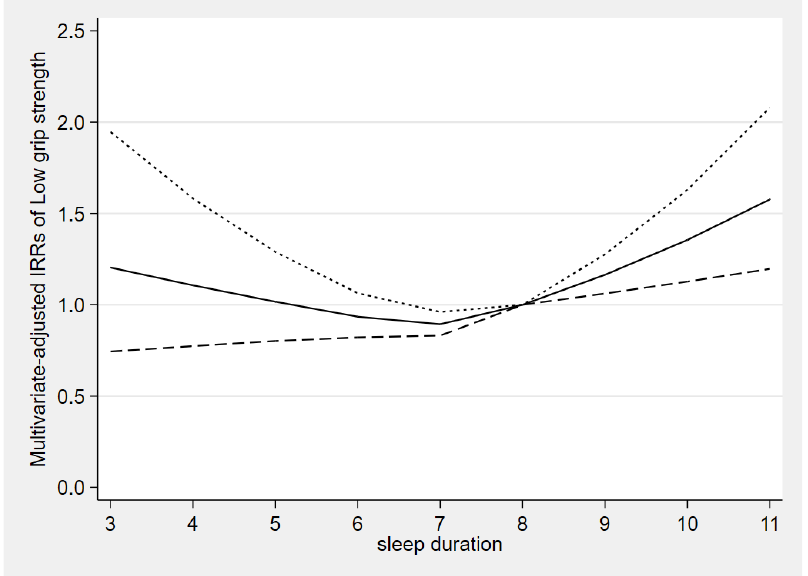
Figure 2. The dose-response relationship between sleep duration and the risk of low grip strength. Adjusted for race, marital status, education level, annual household income, physical activity, cog- nitive function, functional limitations, ADL limitations, caffeine intake, total energy intake, total testosterone level, smoking status, drinking status, medical history (hypertension, diabetes, cancer, stroke, arthritis, and coronary heart disease), as well as depressive symptoms. Reference is 8 h/day. The solid line and dash line represent the estimated IRRs and their 95% confidence intervals, respec- tively. IRR: incidence-rate